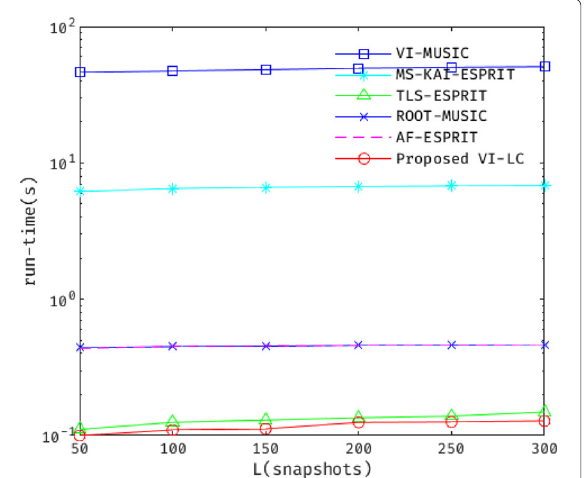
Fig. 3 Complexity comparison versus